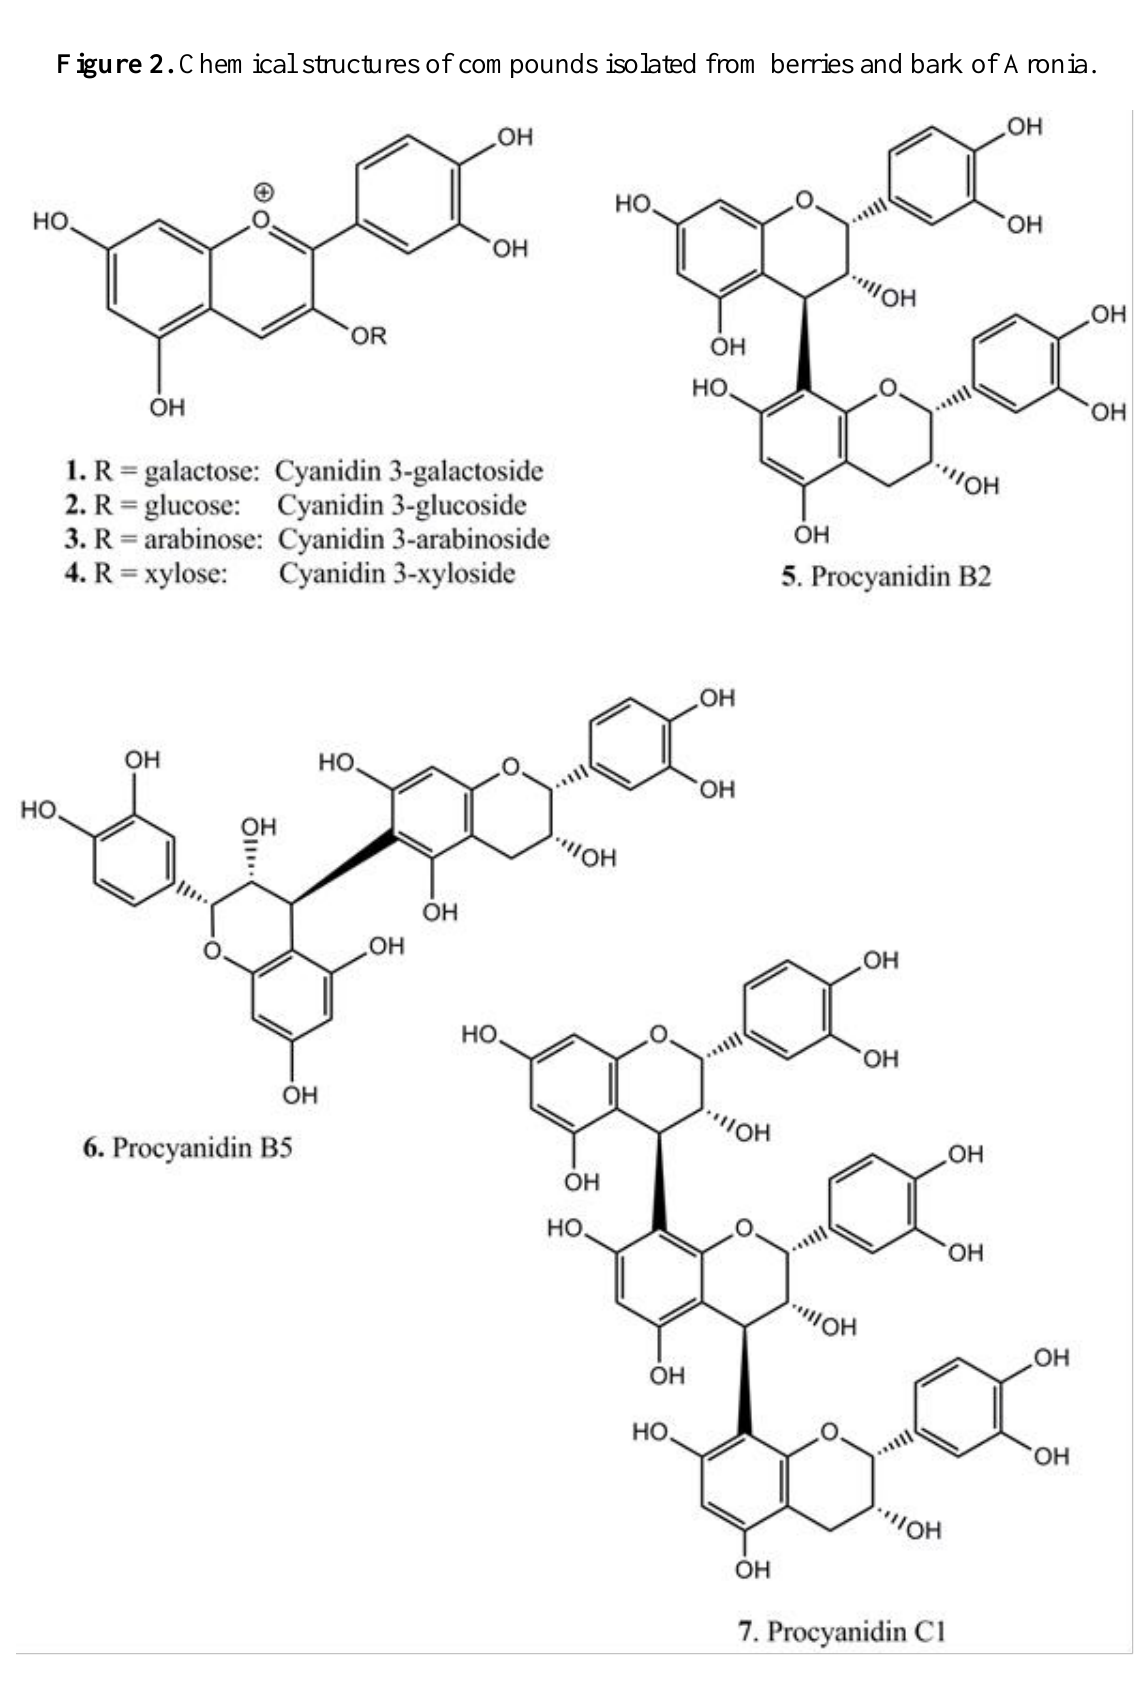
Figure 2. Chemical structures of compounds isolated from berries and bark of